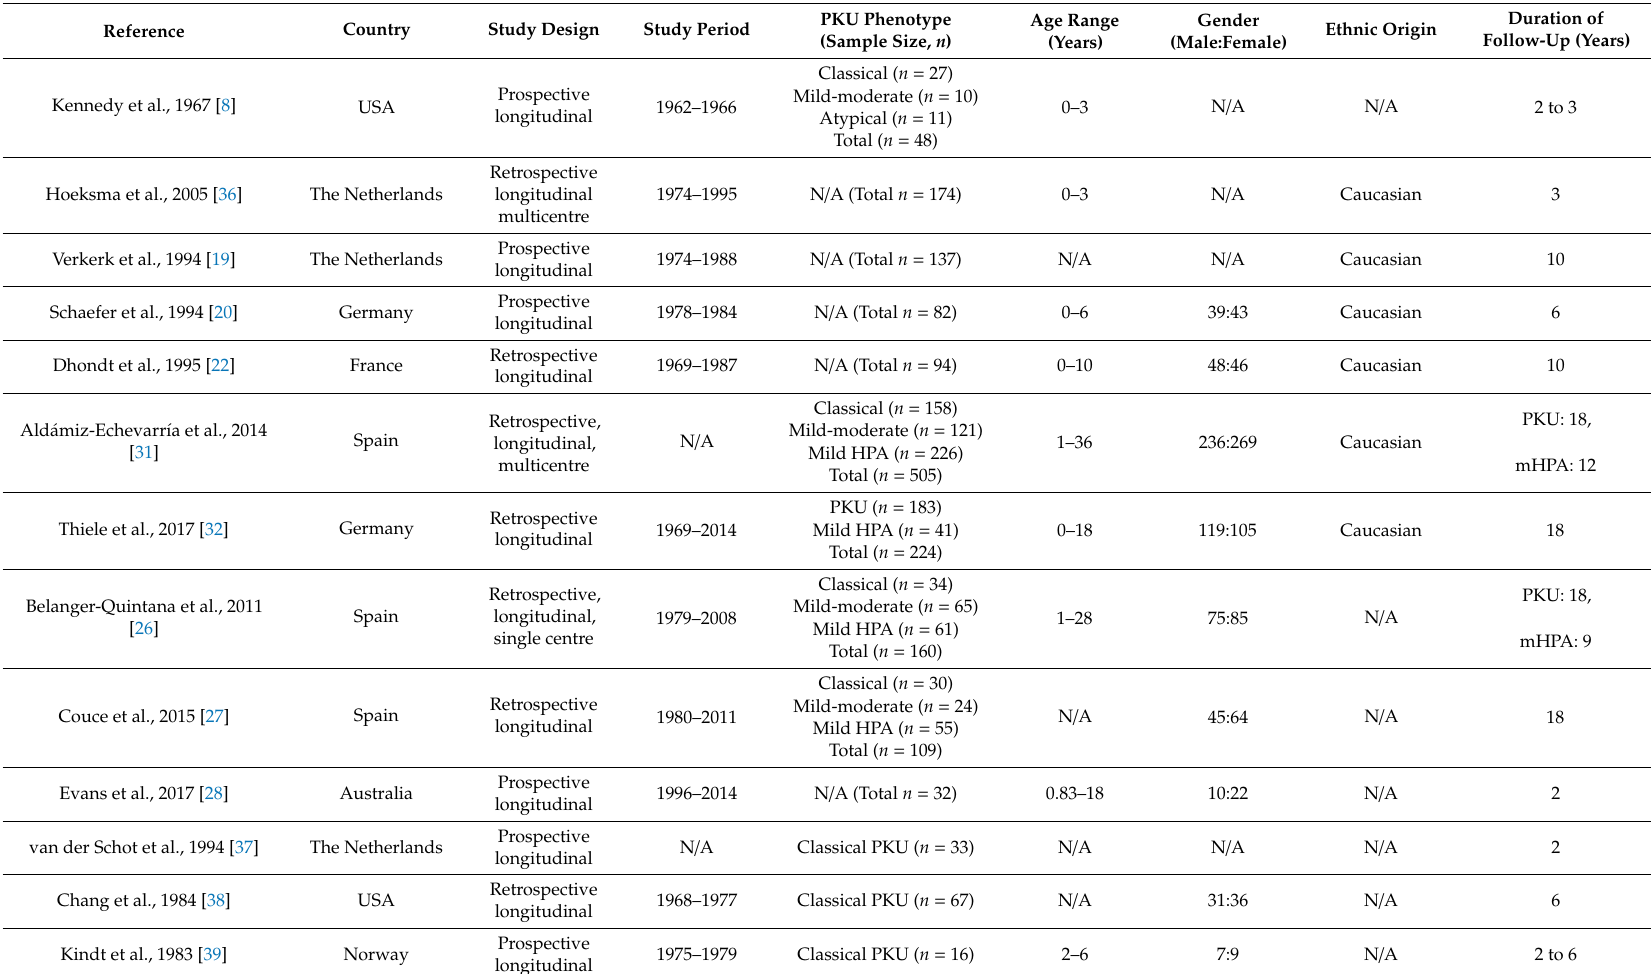
Table 1. Main characteristics of included